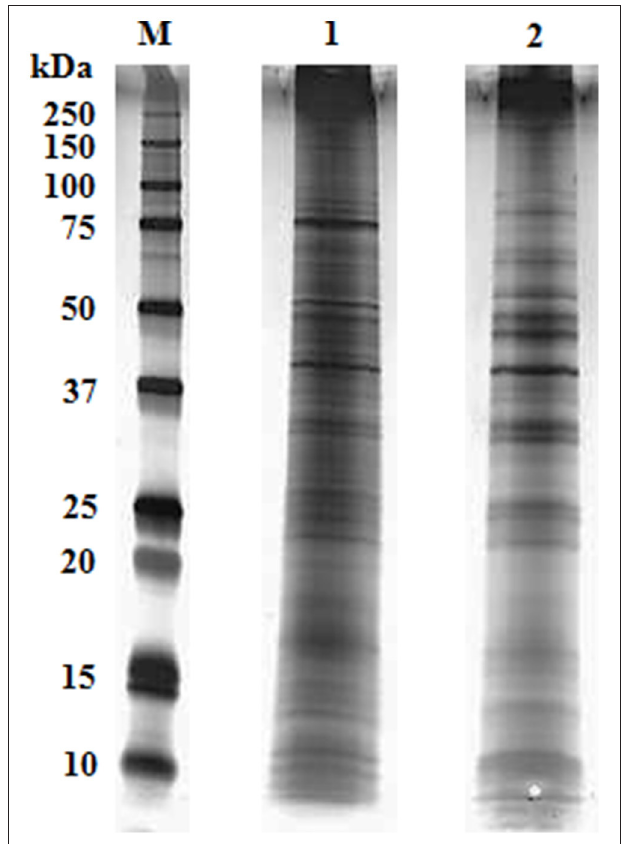
FIGURE 1 | Representative overlay of silver-stained gel image of H . diminuta cysticercoid and adult tapeworm proteins after separation by 1-DE (M- marker, 1- cysticercoid, 2- adult tapeworm).